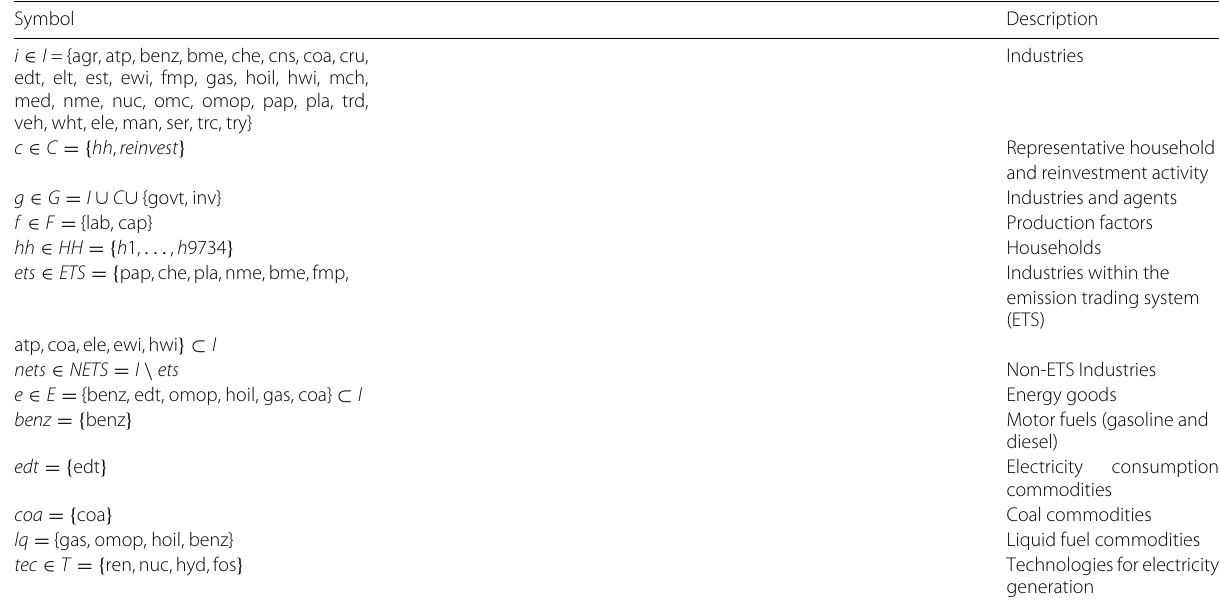
Table 13 Sets in the CEPE